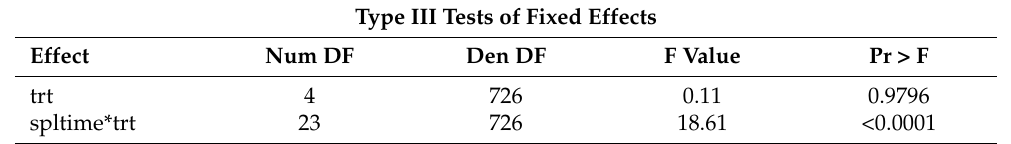
Table A3. Test of Fixed Effects for growth